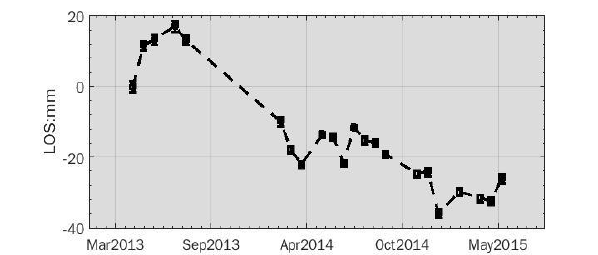
Figure 5. Deformation of point C